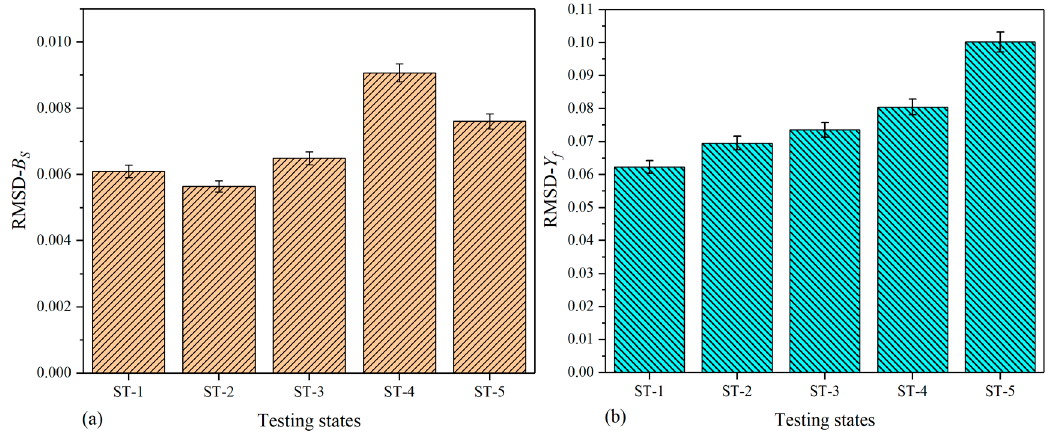
Figure 15. RMSD based on real part of signatures for fuselage: ( a ) raw conductance signatures G s , ( b ) extracted DCMI signatures X f .